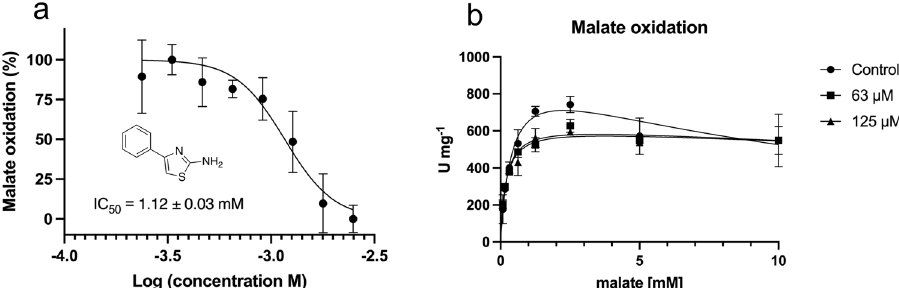
Fig. 5 Study of the biological response of Pf MDH in the presence of 4PA. a Left part: dose/response inhibition of P f MDH. Data are presented as mean ± SEM ( n = 3 biologically independent experiments). b Kinetics studies of two different concentrations of 4PA vs. control (DMSO) using the substrate inhibition model. Experiments were carried in the same plate. y -Axis shows enzyme activity expressed as U = μ mol of NAD + reduced per minute by 1.0 mg of Pf MDH. Data are presented as mean ± SEM ( n = 3 biologically